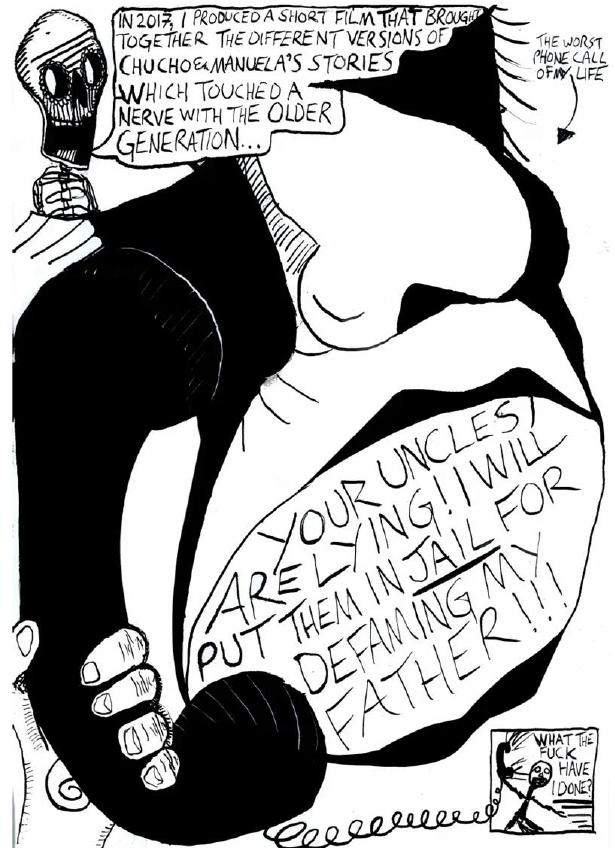
Figure 7: The phone call with my great-aunt as featured in Breaking Tezcatlipoca (Sherwood Gonzalez 2019, 18) A few weeks after the phone call, my great-aunt, grandparents, my aunt, my uncle, my step-father, my mother, my partner and I went to watch Coco (Molina and Unkrich 2017) at the cinema, Disney Pixar’s interpretation of Mexican celebrations of the Day of the Dead. The plot consists of the hero of the story, Miguel, searching through the underworld for a family member that would give him the blessing to be a musician, in spite of the fact his living (and dead) family are denying him the ability to express himself musically. Thematically, Coco breaks down intergenerational traumas and borders shared between latinx family members in a playful and emotive way. I remember at the end of the film, we were all in tears and kissing and hugging each other. It was an incredibly cathartic moment for myself and Tita and reconciliation both in the film’s but also our reality. That b eing said, I did not know how to integrate many of the complex feelings I had around the seismic impact of my great- aunt’s response to my work. I was stuck between a rock and a hard place: do I appease my great-aunt and prioritise her voice over everyone else's, in spite of the work I had already been cultivating around polyvocal